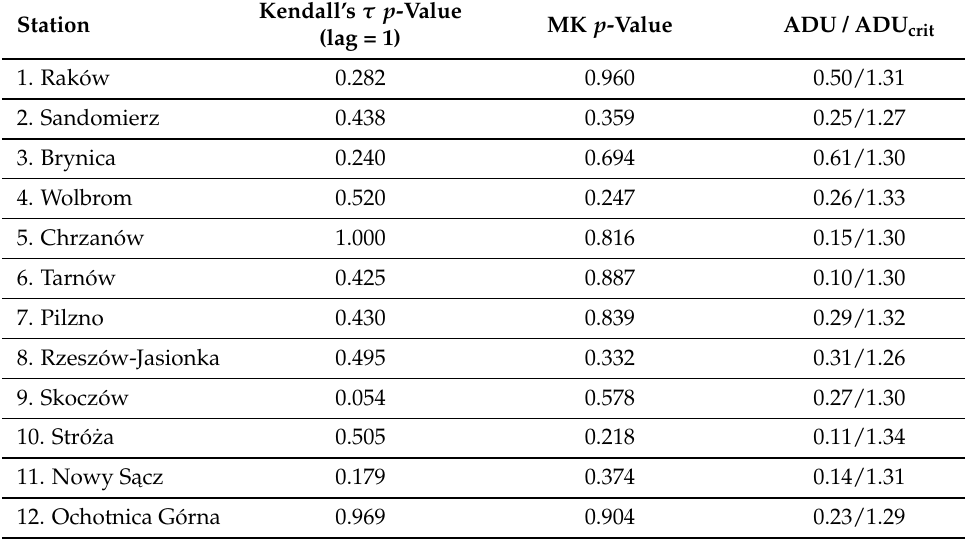
Table 3. The p -values of the test of the Kendall’s τ (column 2), the MK test (column 3), and the ADU test statistics and the critical values ADU crit (column